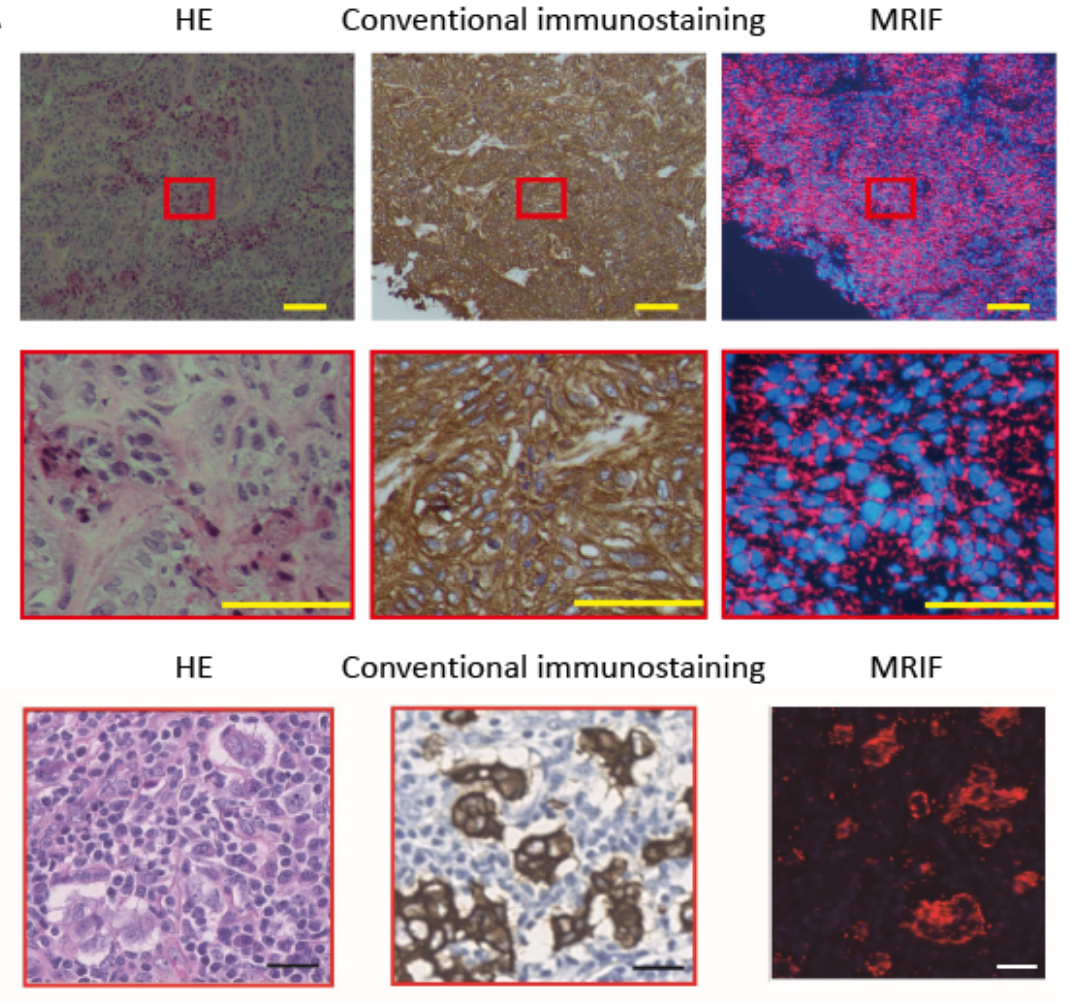
Figure 7. ( A ): Staining of A431 cells by hematoxylin–eosin (HE) ( left ), conventional immunostaining ( middle ), and MRIF ( right ). Images of an A431 (human epidermoid cancer cells with high expression of epidermal growth factor receptor (EGFR)) xenograft in pigs. ( B ): Staining image of a human breast cancer metastatic lymph node by HE ( left ), conventional immunostaining ( middle ), and MRIF ( right ) incubated with anti-pan-cytokeratin antibody-coated FF beads. Image of a paraffin-embedded tissue array of a stained human breast cancer metastatic lymph node. Scale bar = 250 µ m and 25 µ m for high magnification. Adapted from Onishi et